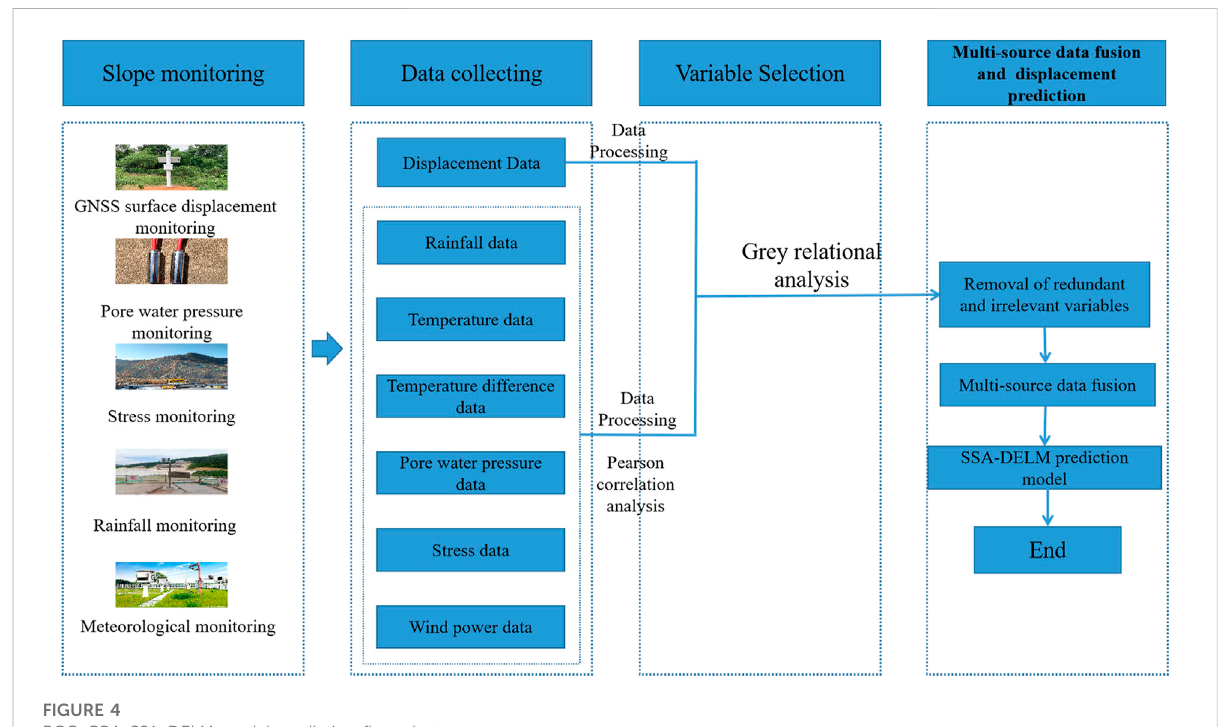
FIGURE 4 PCC-GRA-SSA-DELM model prediction fl ow chart.